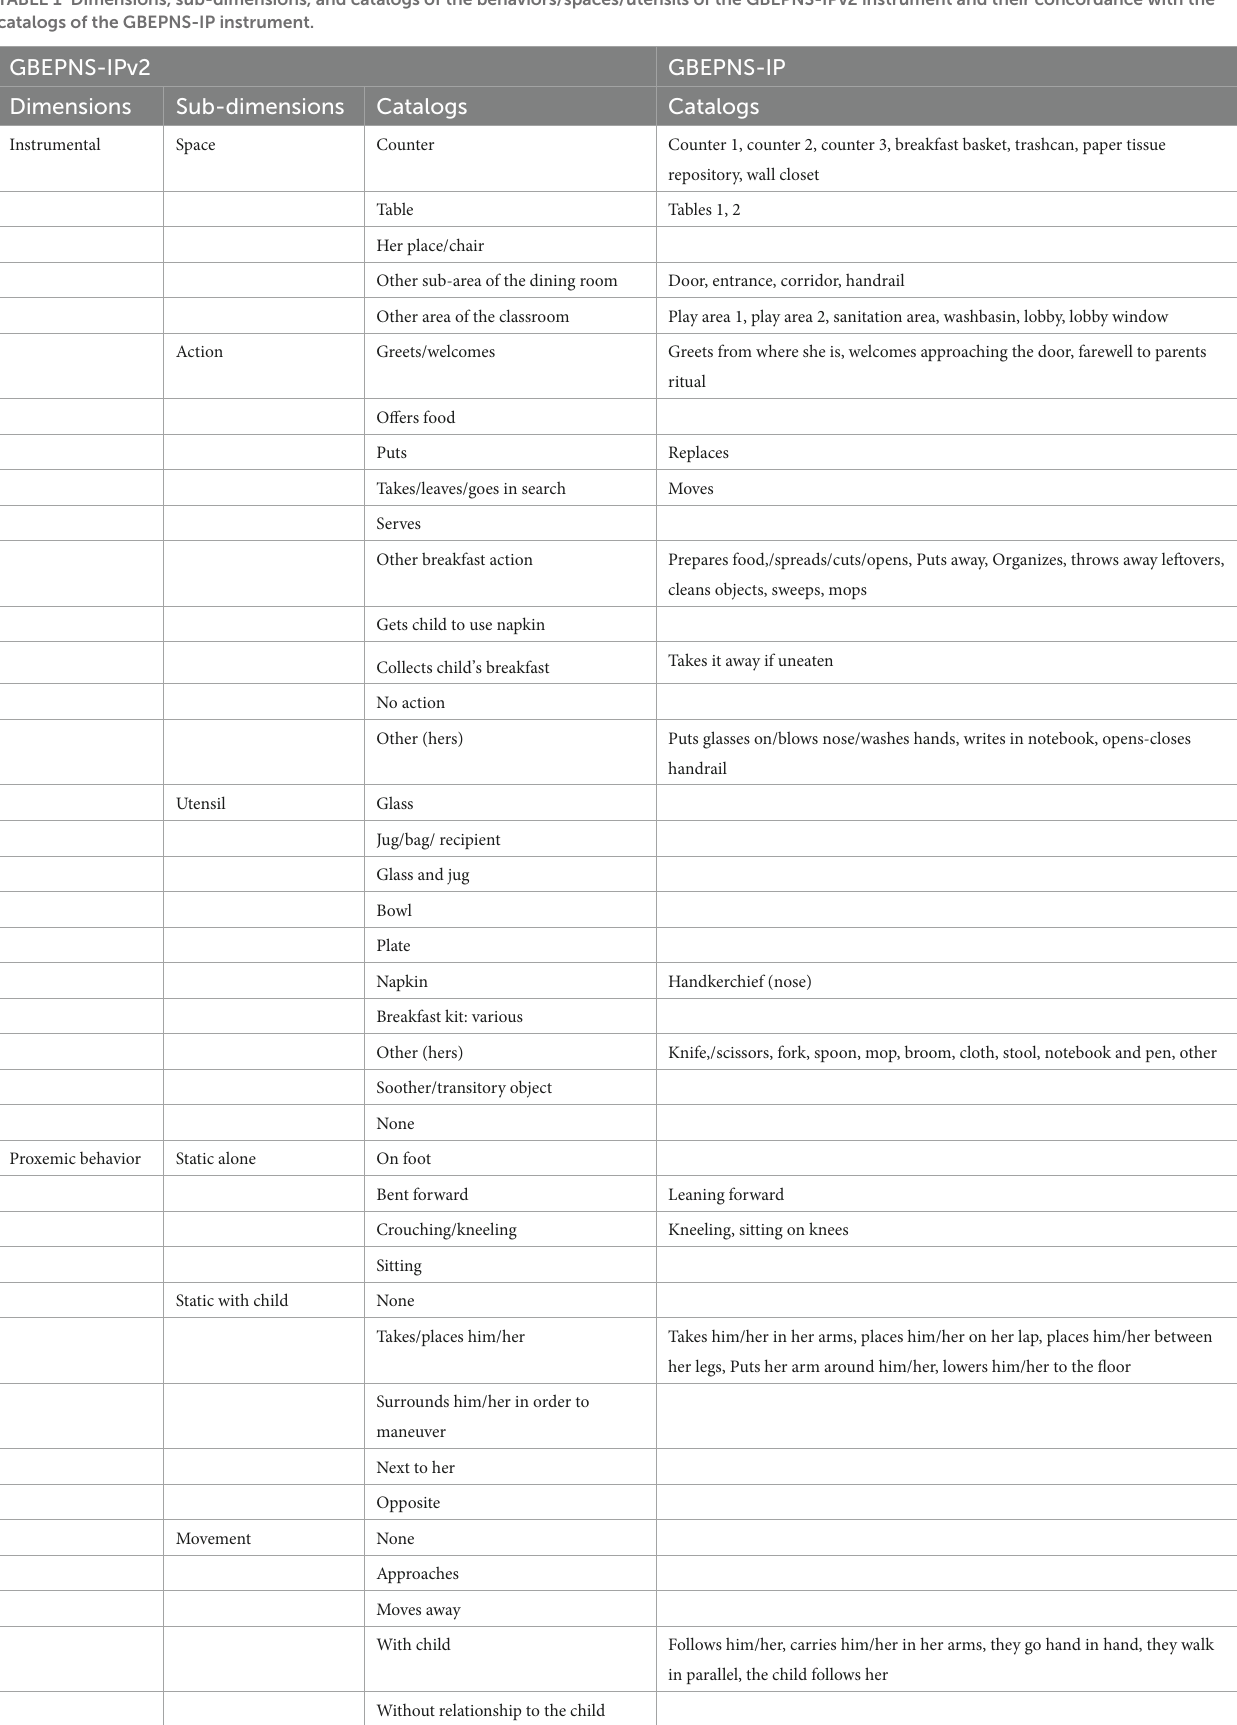
TABLE 1 Dimensions, sub-dimensions, and catalogs of the behaviors/spaces/utensils of the GBEPNS-IPv2 instrument and their concordance with the catalogs of the GBEPNS-IP instrument. GBEPNS-IPv2